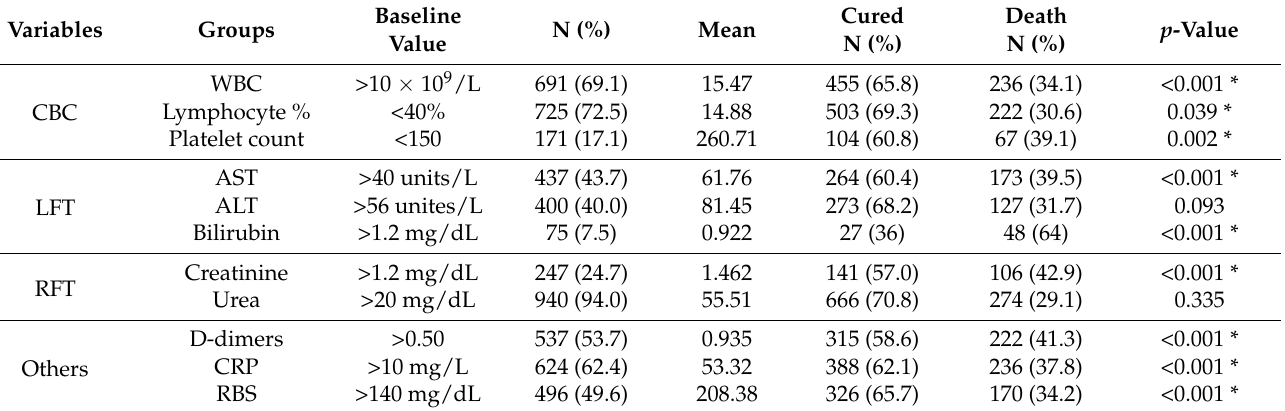
Table 3. Laboratory parameters of patients having SARS-CoV-2 Infection.